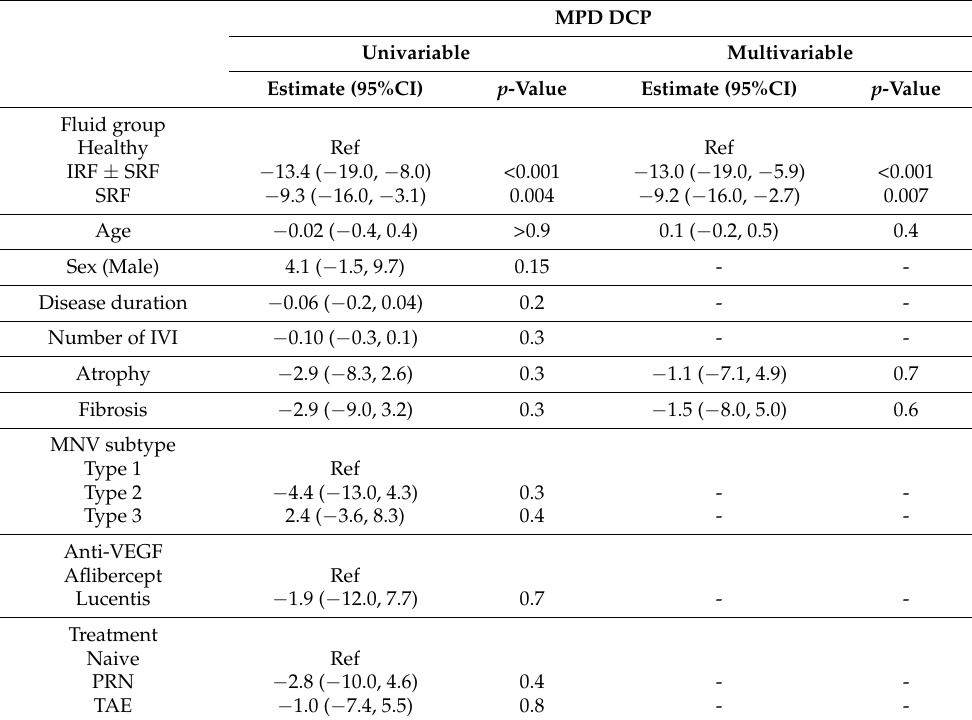
Table 7. Effect of time on mean vascular density (MVD) according to the patient group and plexus analyzed. The analyses were performed using a multivariable linear mixed effects model including age, fibrosis and atrophy as covariates. The estimate gives the increase or decrease in the variable between T0 and T1 independently of age, fibrosis and atrophy. T0 T1